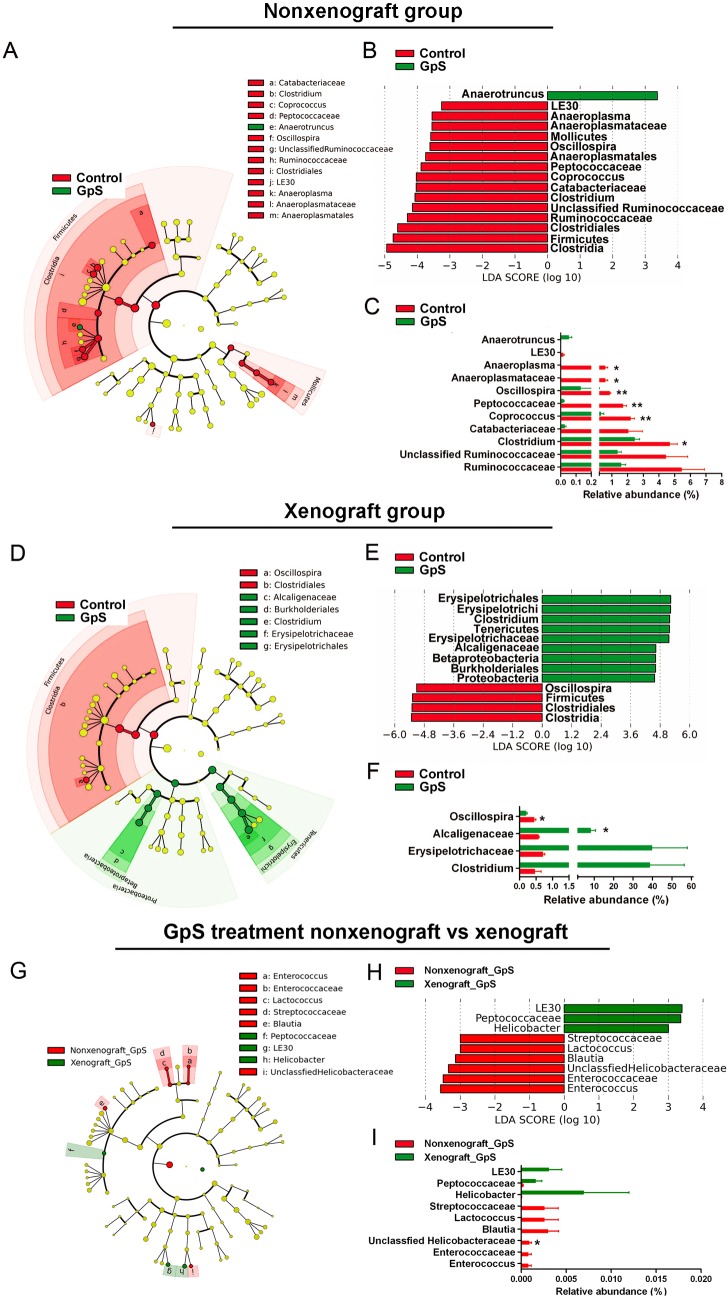
LEfSe analysis of pyrosequencing data obtained from different experimental groups.Effects of GpS on fecal microbiome in nonxenograft (A-C) and xenograft (D-F) nude mice. Data are presented as the mean ± SEM (* P < 0.05, ** P < 0.01, versus control group, n = 3/group). (G) to (I): comparison of differentially abundant bacterial populations between the nonxenograft and xenograft groups treated with GpS, data are presented as the mean ± SEM (* P < 0.05, xenograft versus nonxenograft group, n = 3/group). (A), (D), & (G): taxonomic representations of fecal microbiome. (B), (E), & (H): histograms of the LDA scores for differentially abundant clades. (C), (F), & (I): the relative abundance of differentially abundant families and genera.